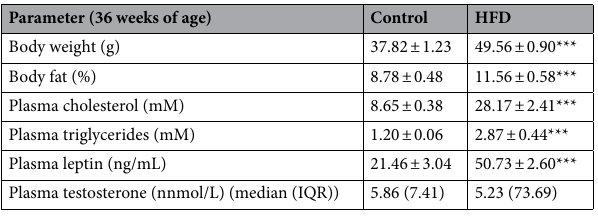
Table 1. Metabolic parameters. *p < 0.05, ***p < 0.001 35 . IQR Interquartile